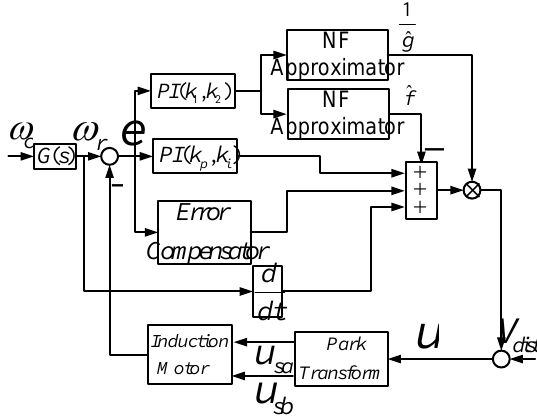
Figure 1. The structure of proposed control